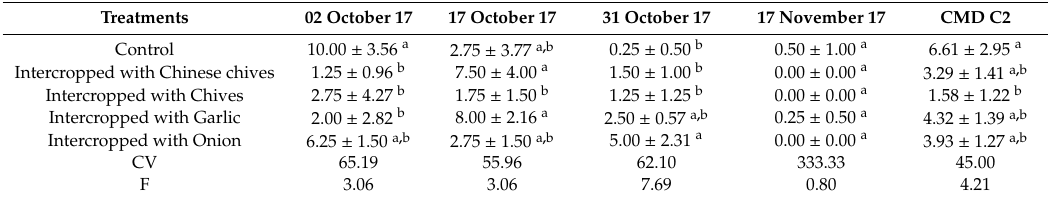
Table 4. Mean number ( ± Standard deviation) of Tetranychus urticae mobile forms and cumulated mite days (CMD) per cm 2 , on strawberry leaves, submitted Amaryllidaceae plants intercropping in second cycle. Londrina, Paran á , Brazil, October–November